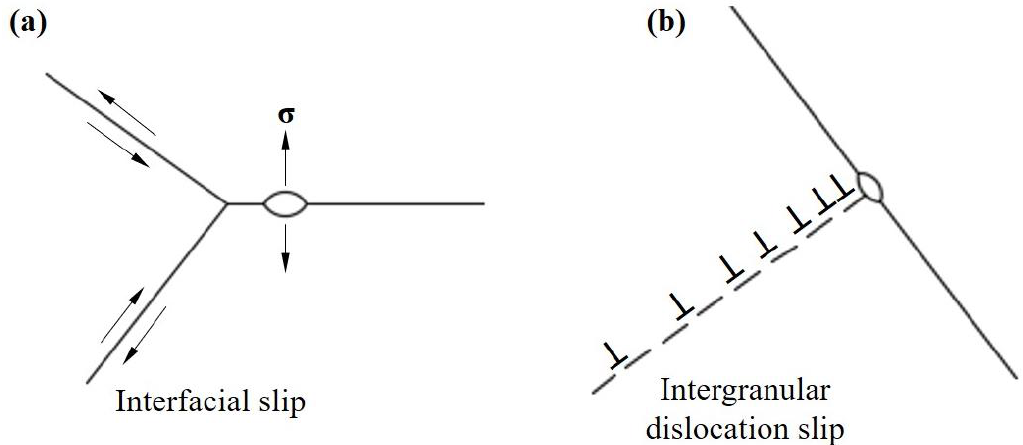
Figure 7. Microvoid nucleation mechanism: ( a ) microvoid initiates near the triple point of 2d interface, ( b ) interfacial microvoid caused by intergranular dislocation slip.